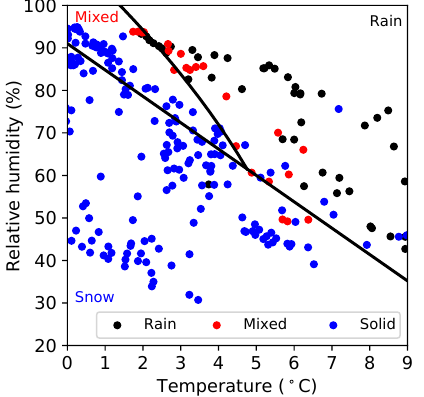
Figure 2. The types of precipitation with respect to the temperature and relative humidity for all the events over the March–April 2015 period using the manual observations and the weather station. The background threshold lines are from Matsuo et al.